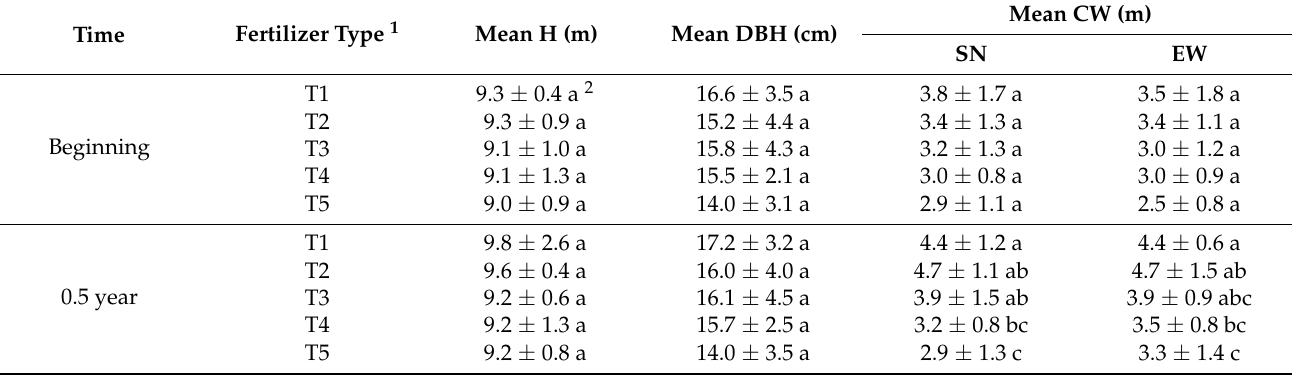
Table 5. Differences in height, diameter at breast height, and crown width of Pinus tabuliformis